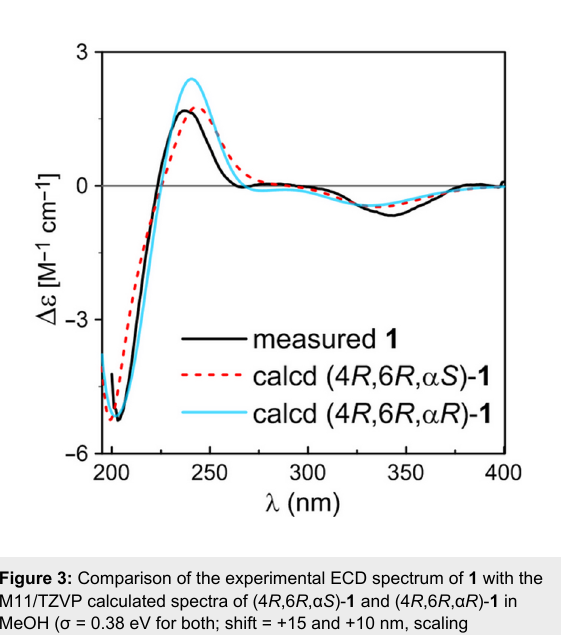
Figure 3: Comparison of the experimental ECD spectrum of 1 with the M11/TZVP calculated spectra of (4 R ,6 R , α S )- 1 and (4 R ,6 R , α R )- 1 in MeOH ( σ = 0.38 eV for both; shift = +15 and +10 nm, scaling factor = 0.50 and 1.0, respectively).